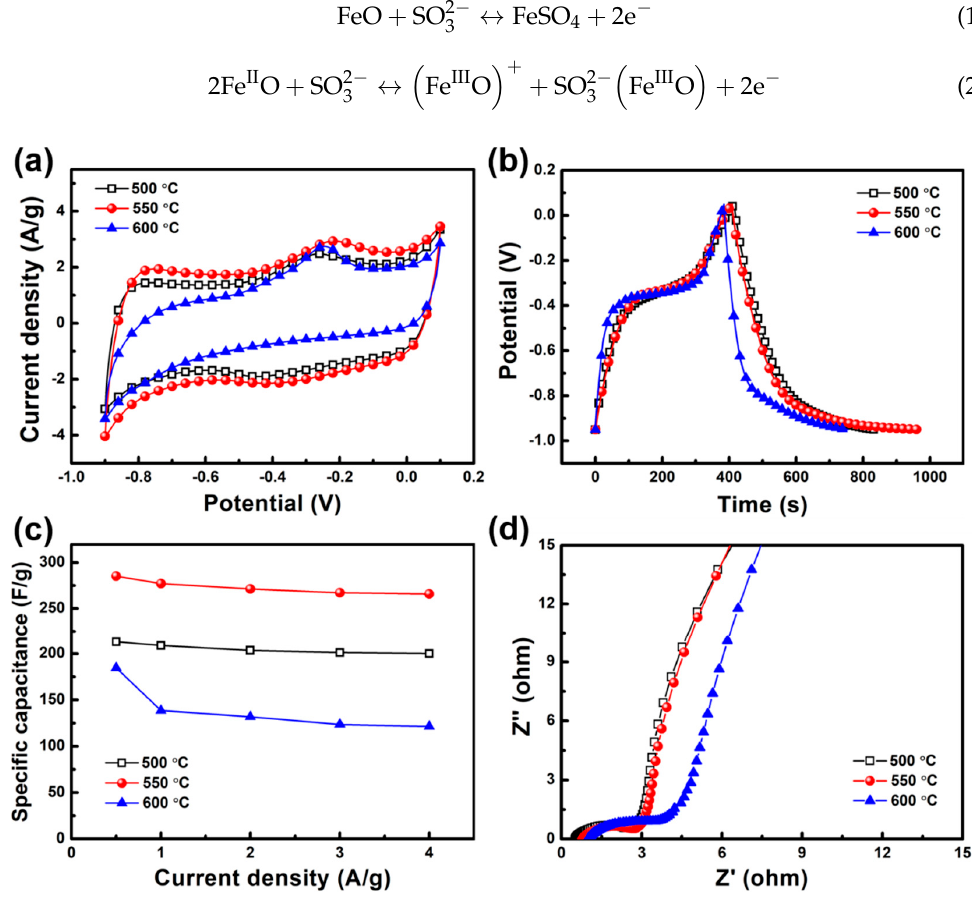
Figure 3. Electrochemical performance of the Fe 3 O 4 /VACNTs composites annealed at different temperatures in 1M Na 2 SO 3 : ( a ) CV curves at 20 mV/s. ( b ) GCD curves at 0.5 A/g. ( c ) Specific capacitance at various current densities. ( d ) EIS spectra.